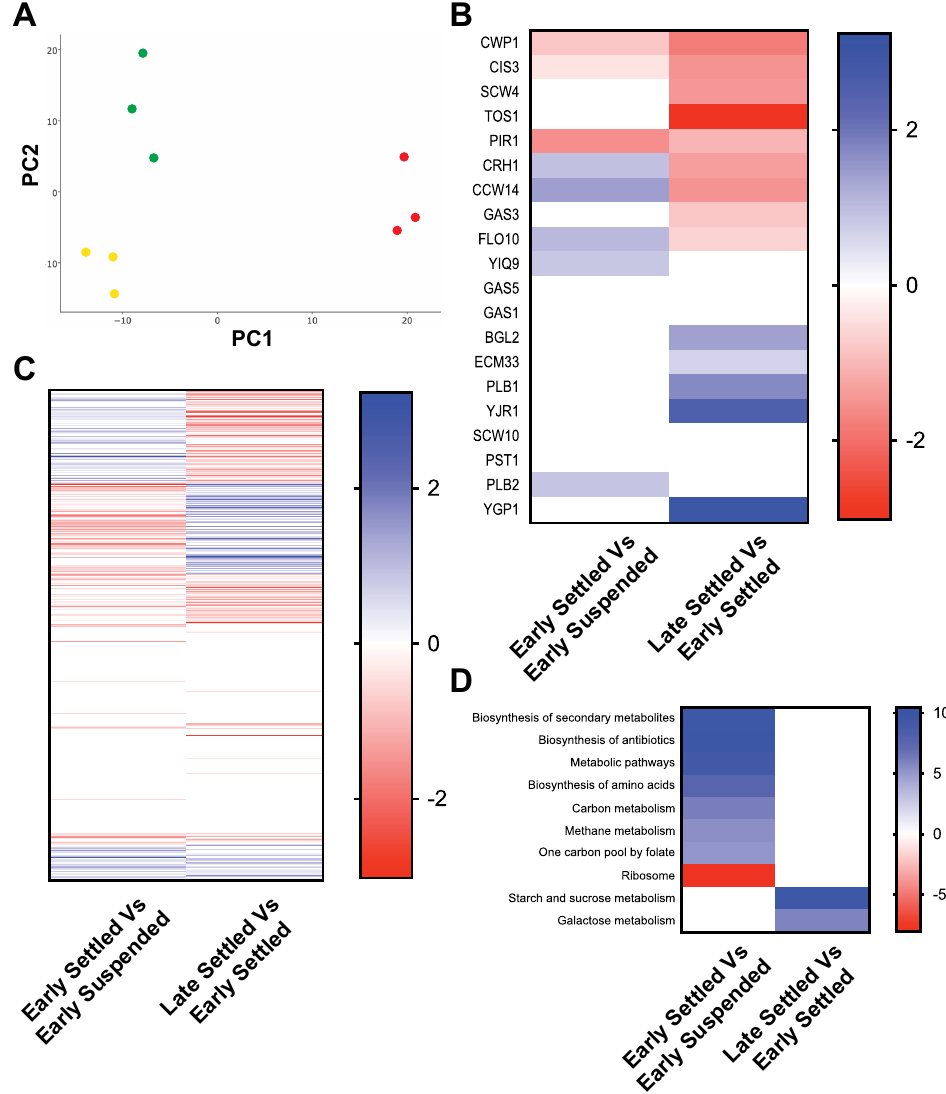
Figure 4. Proteomic comparison of English ale WLP002 across the course of fermentation. ( A ) Principle component analysis of whole cell proteome. Colored by stage of fermentation: Early Suspended (yellow), early settled (green) and late settled (red). The first component ( x -axis) accounted for 37.56% of the total variance and the second component accounted for an additional 20.25%; ( B ) heat map of cell wall proteins that are different in WLP002: early settled cells compared to early suspended cells, and late settled cells compared to early settled cells; ( C ) heat map of whole cell proteins that are different in WLP002: Early settled cells compared to early suspended cells, and late settled cells compared to early settled cells. Values in heat map ( A , B ) are shown as log 2 (fold change) for proteins with significantly different abundances ( p < 10 − 5 ) in the relevant comparisons; ( D ) heat map of significantly enriched pathways identified by DAVID analysis. Values shown as − log 2 of Benjamini corrected p -value for pathways which were significantly enriched ( p <